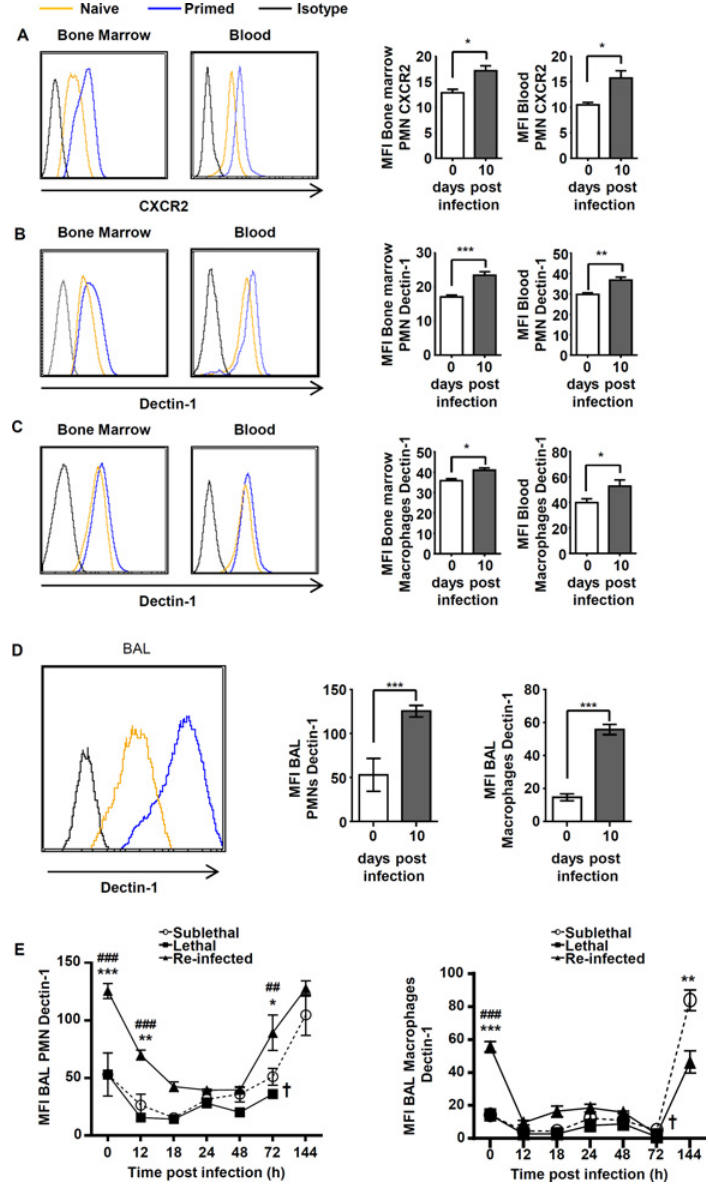
Fig 6. A sublethal infection primes bone marrow and blood phagocytes to increased Dectin-1 and CXCR2 expression. To investigate the priming process following the subethal infection, mice were either sacrificed at day 0 (Na ï ve) or at day 10 following infection with the sublethal dose (Primed). (A) CXCR2 expression on bone marrow and blood neutrophils (GR1 high CD11b + population). Dectin-1 expression levels on bone marrow and blood neutrophils (GR1 high CD11b + population) (B), and macrophages (F4/ 80 + CD11b + GR-1 - population) (C). (D) Dectin-1 expression levels on BAL neutrophils and macrophages. Representative histograms show level of expression (left panel) and quantification of respective values in graphs (right panel). (E) Dynamic of Dectin-1 level expression on both neutrophils (left panel) and macrophages (right panel) in the BALs in the three infection settings. “ SL ” or “ L ” mice were sacrificed at 0 h (na ï ve), 12 18, 24, 48, 72 and 144 h p.i. and “ Re-inf ” mice were sacrificed at 0 h (10 days after the SL infection, day of the re-infection), 12, 18,24, 48, 72 and 144 h p.i. Data (mean ± SEM) represent 2 to 3 independent experiment with n = 5 mice per experiment. Statistically significant differences were determined using a Two way ANOVA with Bonferroni post-test (+p < 0.05, ++p < 0.01; * p < 0.05, ** p < 0.01, *** p < 0.001Re- Inf vs SL dose; #p < 0.05, ##p < 0.005 ###p < 0.001 LL dose vs Re-Inf